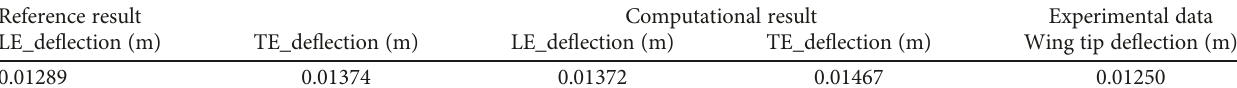
Table 6: The comparison of the de fl ection results of the reference and experimental data.